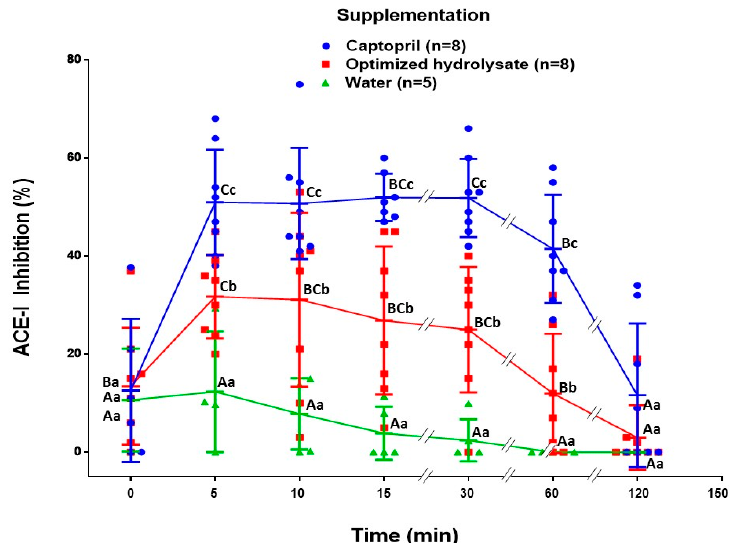
Figure 1. Bioavailability of antihypertensive peptides measured as a percentage of ACE-I inhibition. Sera from mice supplemented with captopril (25 mg/kg), optimized hydrolysate (2.4 gr/kg), and water (0.3 mL) were utilized for the assays. Different upper case letters mean significant differences ( p < 0.05) in the same group (from left to right). Different lower case letters mean significant differences ( p < 0.05) among the groups at specific time points.